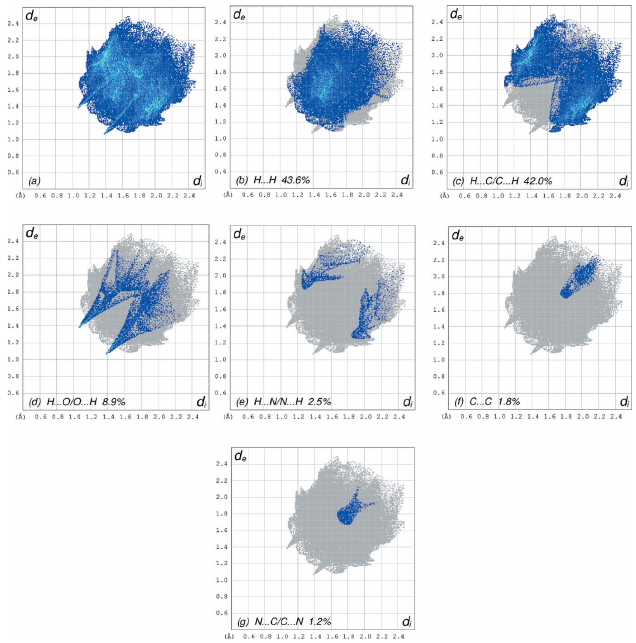
Figure 7 The full two-dimensional fingerprint plots for the title compound, showing ( a ) all interactions, and those delineated into ( b ) H (cid:3)(cid:3)(cid:3) H, ( c ) H (cid:3)(cid:3)(cid:3) C/C (cid:3)(cid:3)(cid:3) H, ( d ) H (cid:3)(cid:3)(cid:3) O/O (cid:3)(cid:3)(cid:3) H, ( e ) H (cid:3)(cid:3)(cid:3) N/N (cid:3)(cid:3)(cid:3) H, ( f ) C (cid:3)(cid:3)(cid:3) C and ( g ) N (cid:3)(cid:3)(cid:3) C/C (cid:3)(cid:3)(cid:3) N interactions. The d i and d e values are the closest internal and external distances (in A˚ ) from given points on the Hirshfeld surface contacts.